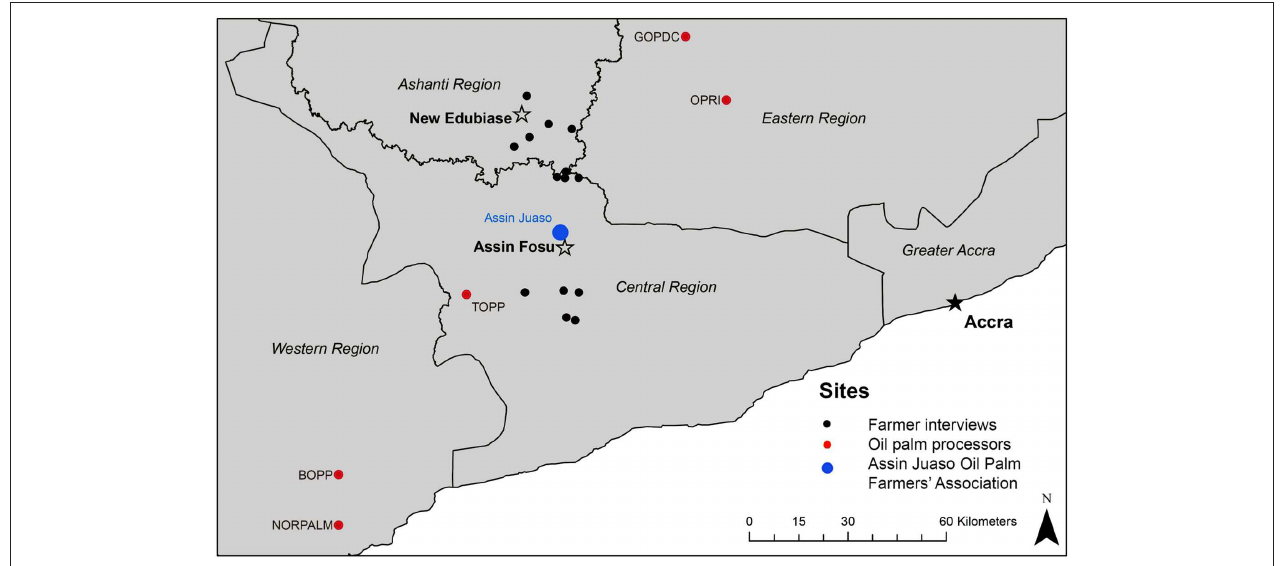
FIGURE 2 | Zoomed in area showing our interview sites and Ghana’s five major oil palm processing sites. White stars represent the towns of New Edubiase and Assin Fosu, with the black star representing the Ghanaian capital of Accra. Source: own figure.